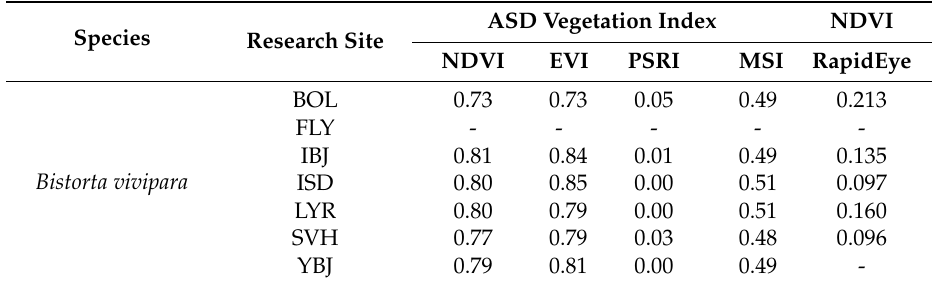
Table 6. Values of vegetation indices: Normalized Difference Vegetation Index (NDVI),